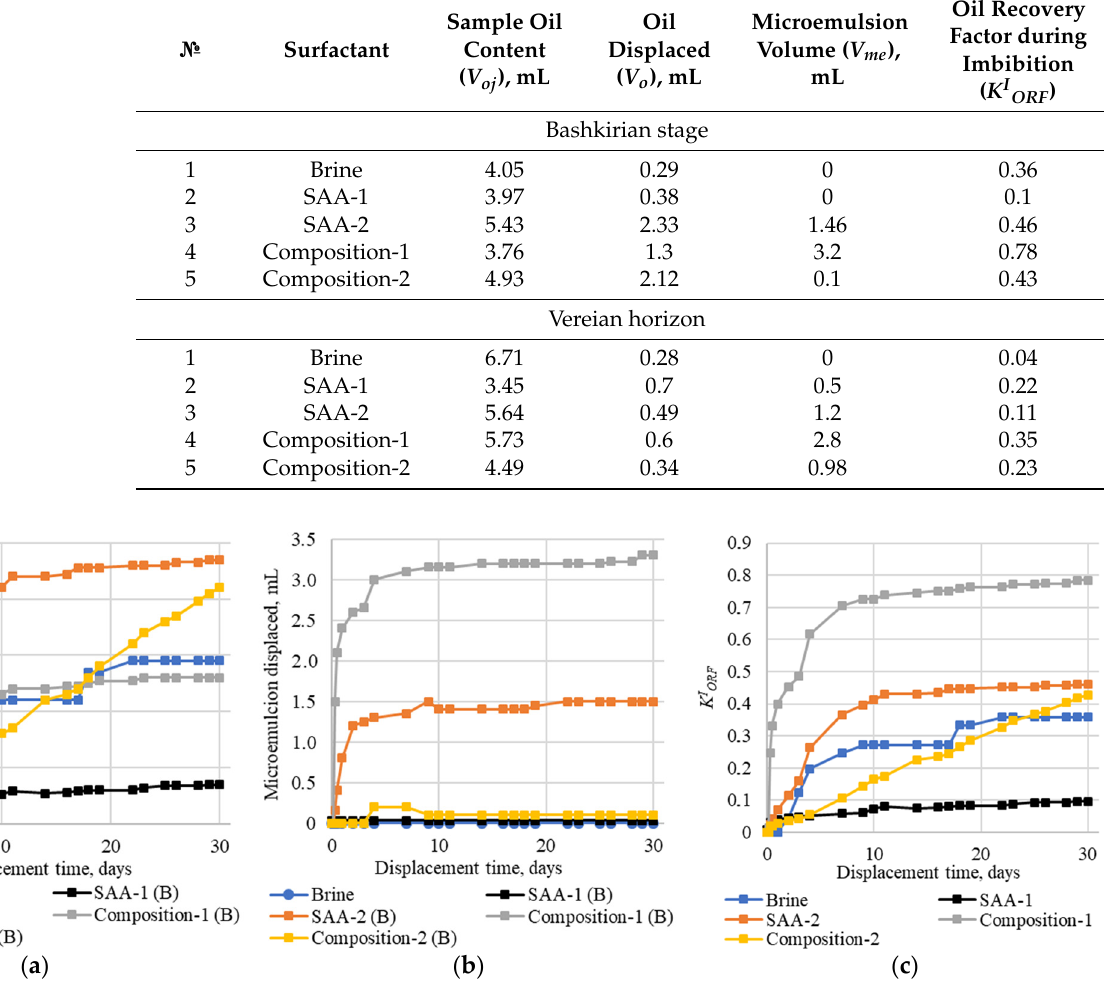
Figure 7. Displacement rate and oil displacement coefficient during capillary impregnation for Bashkirian stage cores of: ( a ) oil; ( b ) microemulsion; ( c ) dynamic of oil displacement coefficient during Amott cell experiment, K IORF unit fraction.